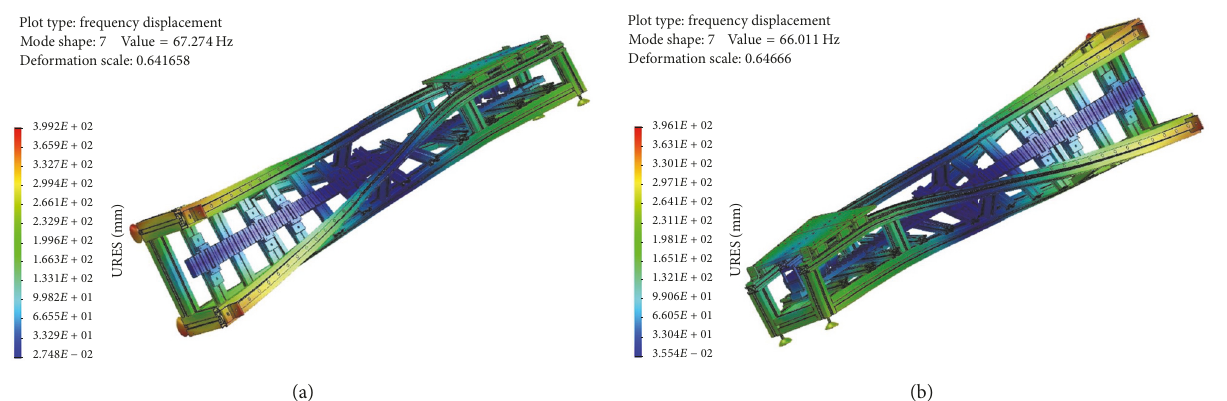
Figure 7: Modal shapes for mode 7: (a) at position P1 ( 𝑓 ≈ 67 Hz, deformation scale ≈ 0.642); (b) at position P5 ( 𝑓 ≈ 66 Hz, deformation scale ≈ 0.646).